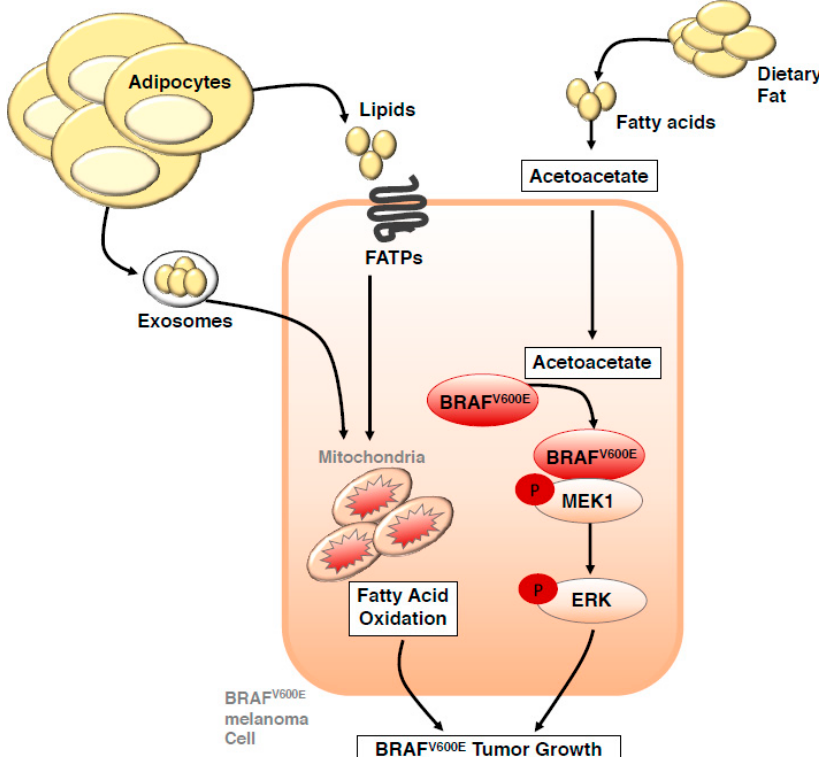
Figure 2. Crosstalk between adipocytes and dietary fat with signalling and metabolism in melanoma cells. Dietary fat and adipocyte-derived lipids have been uncovered as a potential fuel source that can drive melanoma progression. Adipocytes directly transfer lipids to melanoma cells via the fatty acid transporter (FATP; also known as solute carrier family 27, SLC27A) family of proteins and via adipocyte-derived exosomes to promote fatty acid oxidation. Circulating lipids associated with a high-fat diet lead to increased serum levels of acetoacetate, a metabolite that selectively promotes interaction between the mutant BRAF V600 protein and MEK1, thereby promoting oncogenic signaling and tumor growth. BRAF: BRAF serine/threonine kinase. MEK: Mitogen activated protein kinase kinase (also known as MAP2K).